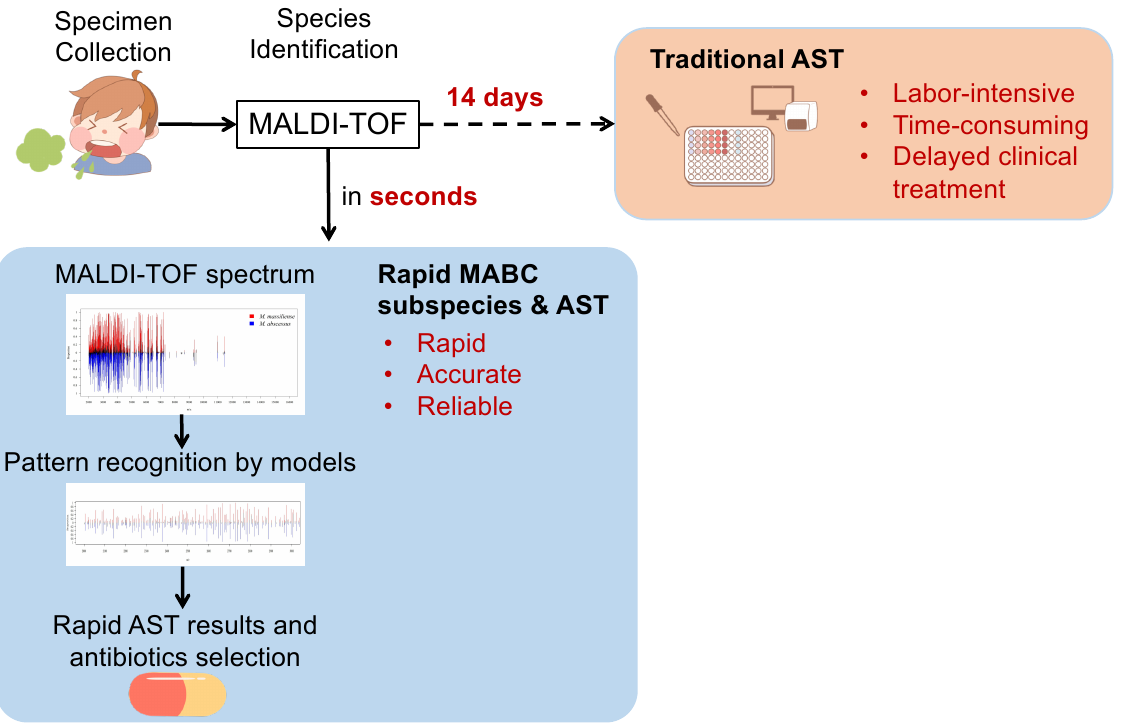
Figure 1. Comparison of the workflows between our research and the traditional approach. Antimi- crobial susceptibility testing (AST) for MABC typically takes 14 days. By contrast, in the current study, we propose a new MALDI–TOF based workflow for rapid MABC subspecies and AST identification in seconds. Based on the rapid and accurate MABC subspecies identification, early and precise management for MABC becomes